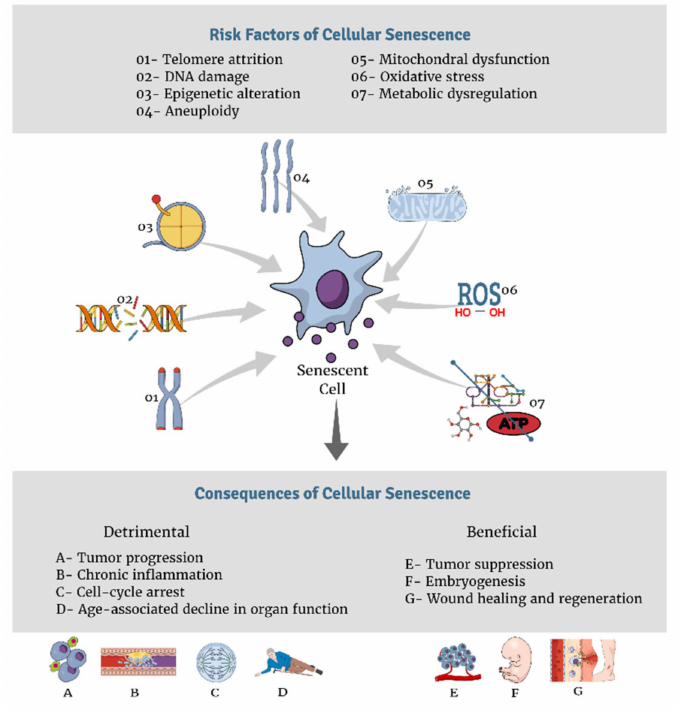
Figure 1. Risk factors and consequences of cellular